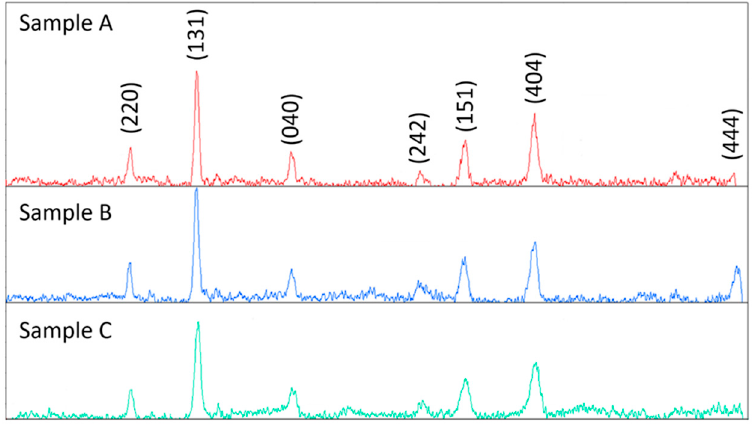
Figure 2. X-ray diffraction patterns of the PVP/metal nitrate composite nanofibers calcined at 750 °C.